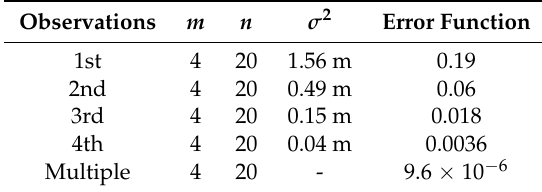
Figure 3. ( a ) Actual locations of the nodes for m = 4 and n = 20; ( b ) Single observation at σ 2 = 1.56 m; ( c ) Single observation at σ 2 = 0.5 m; ( d ) Single observation at σ 2 = 0.15 m; ( e ) Single observation at σ 2 = 0.04 m; ( f ) Multiple observations. Table 4. Parameters setup and error function comparison for second